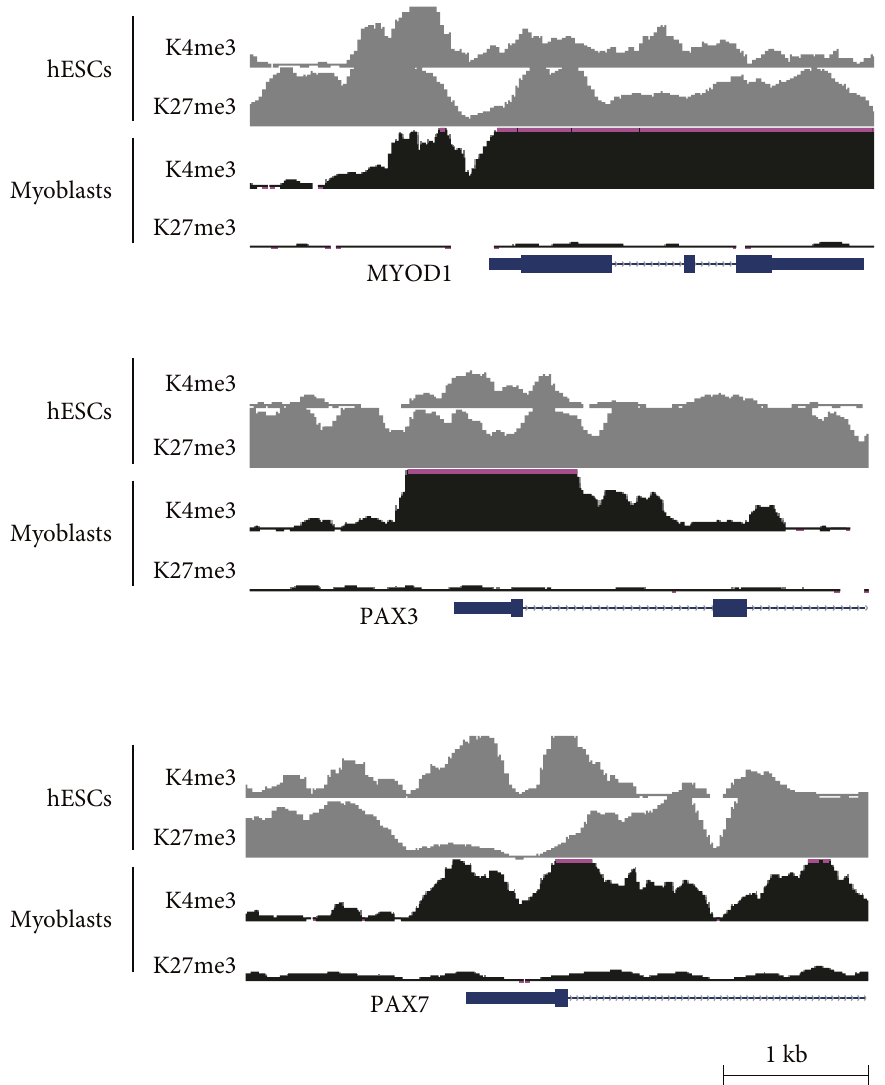
Figure 2: The states of H3K4me3 and H3K27me3 near myogenic genes in hESCs and myoblasts. The ChIP-sequencing peaks of H3K4me3 and H3K27me3 at the MYOD1, PAX3, and PAX7 genes are shown. The data were generated in the Bernstein laboratory